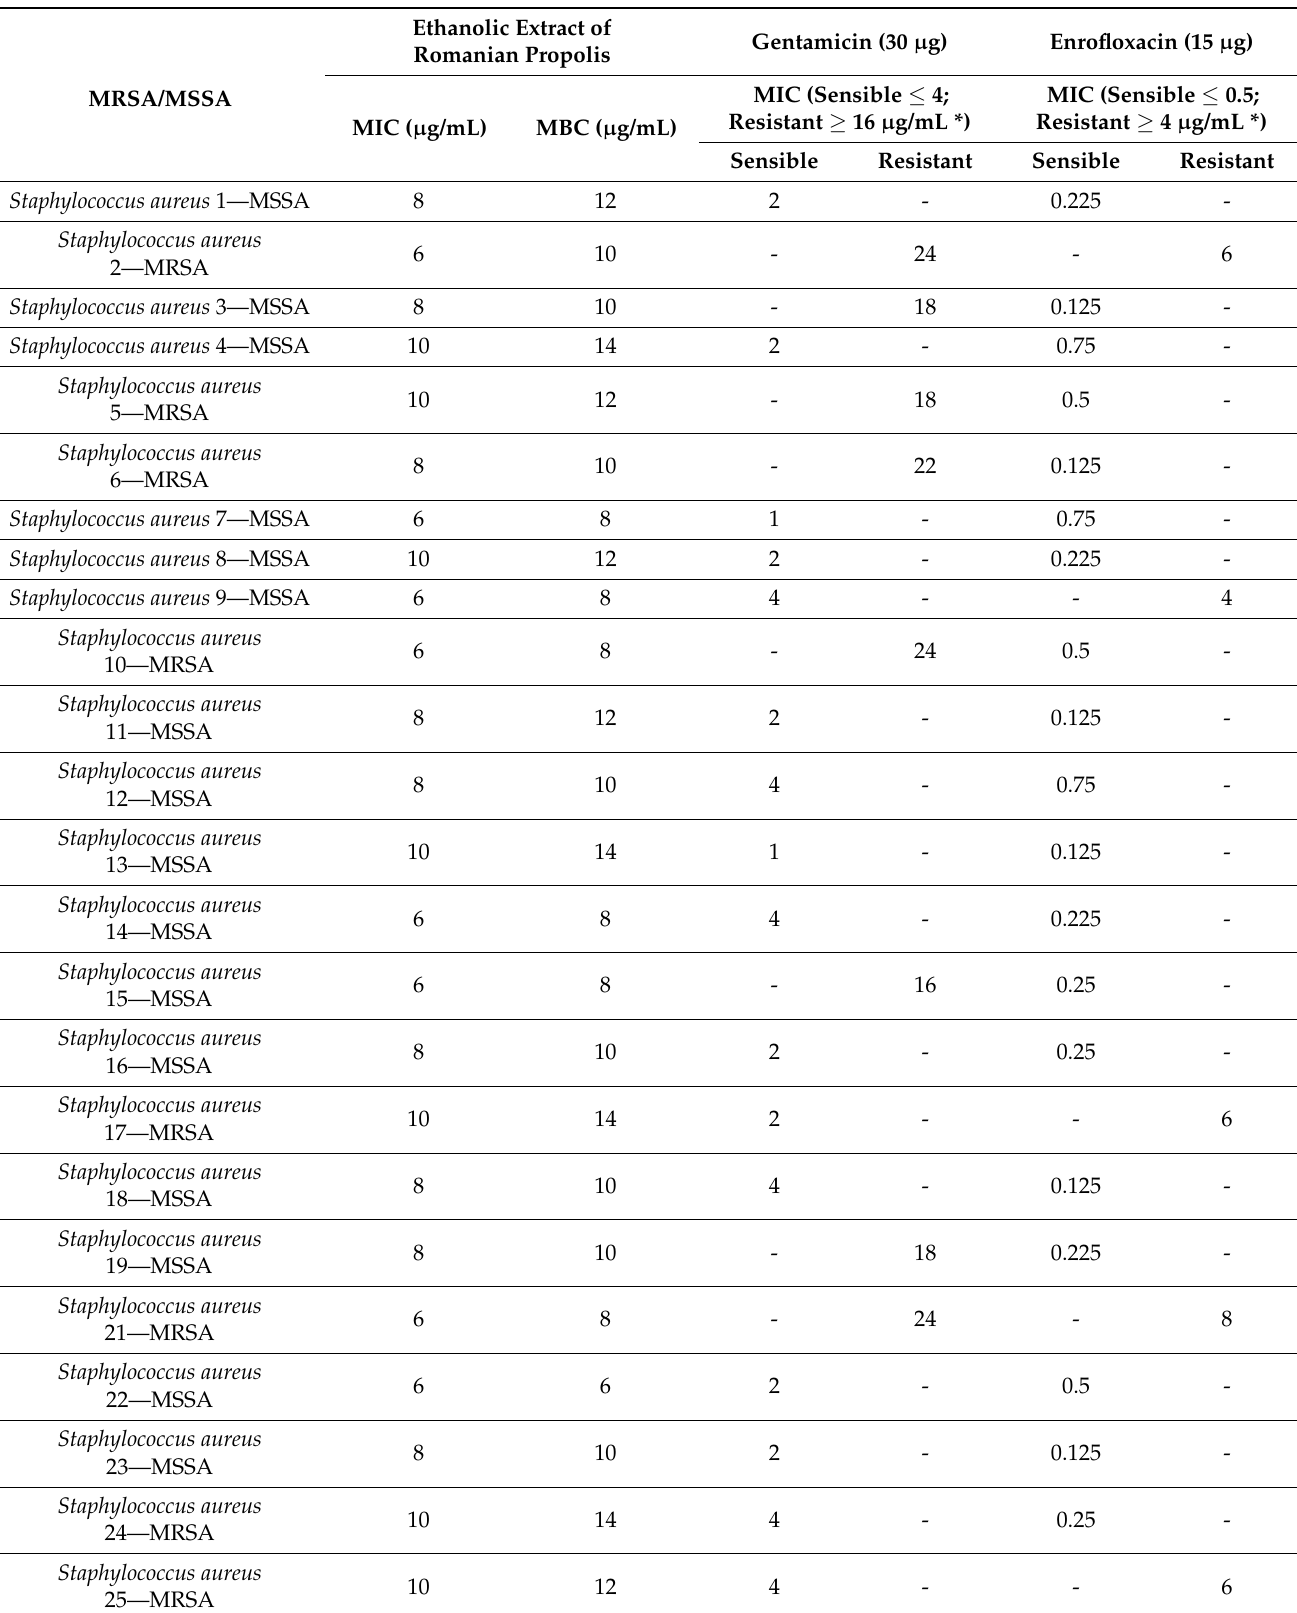
Table 2. MIC and MBC values of ethanolic extract of Romanian propolis and two antibacterial drugs ( µ